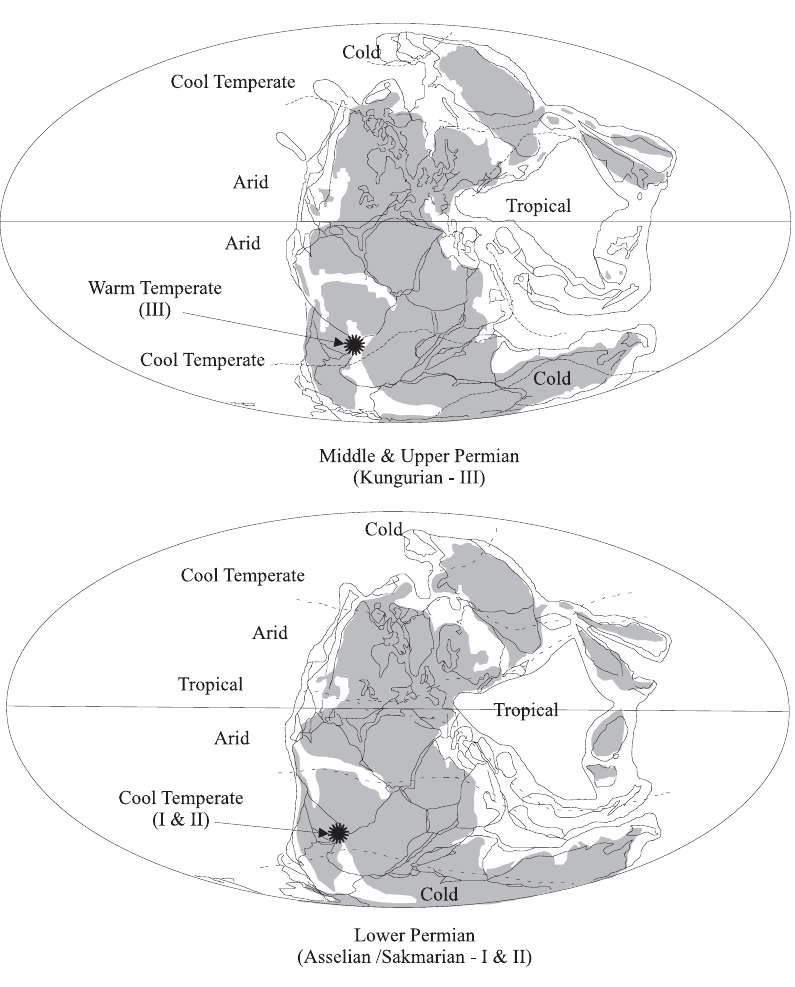
Fig. 7 – Palaeomaps of megafloristic associations in biomes at cold-cool, cool (I-II) and warm temperate (III) climates in the Lower and Midle/Upper Permian (Adapted from Scotese